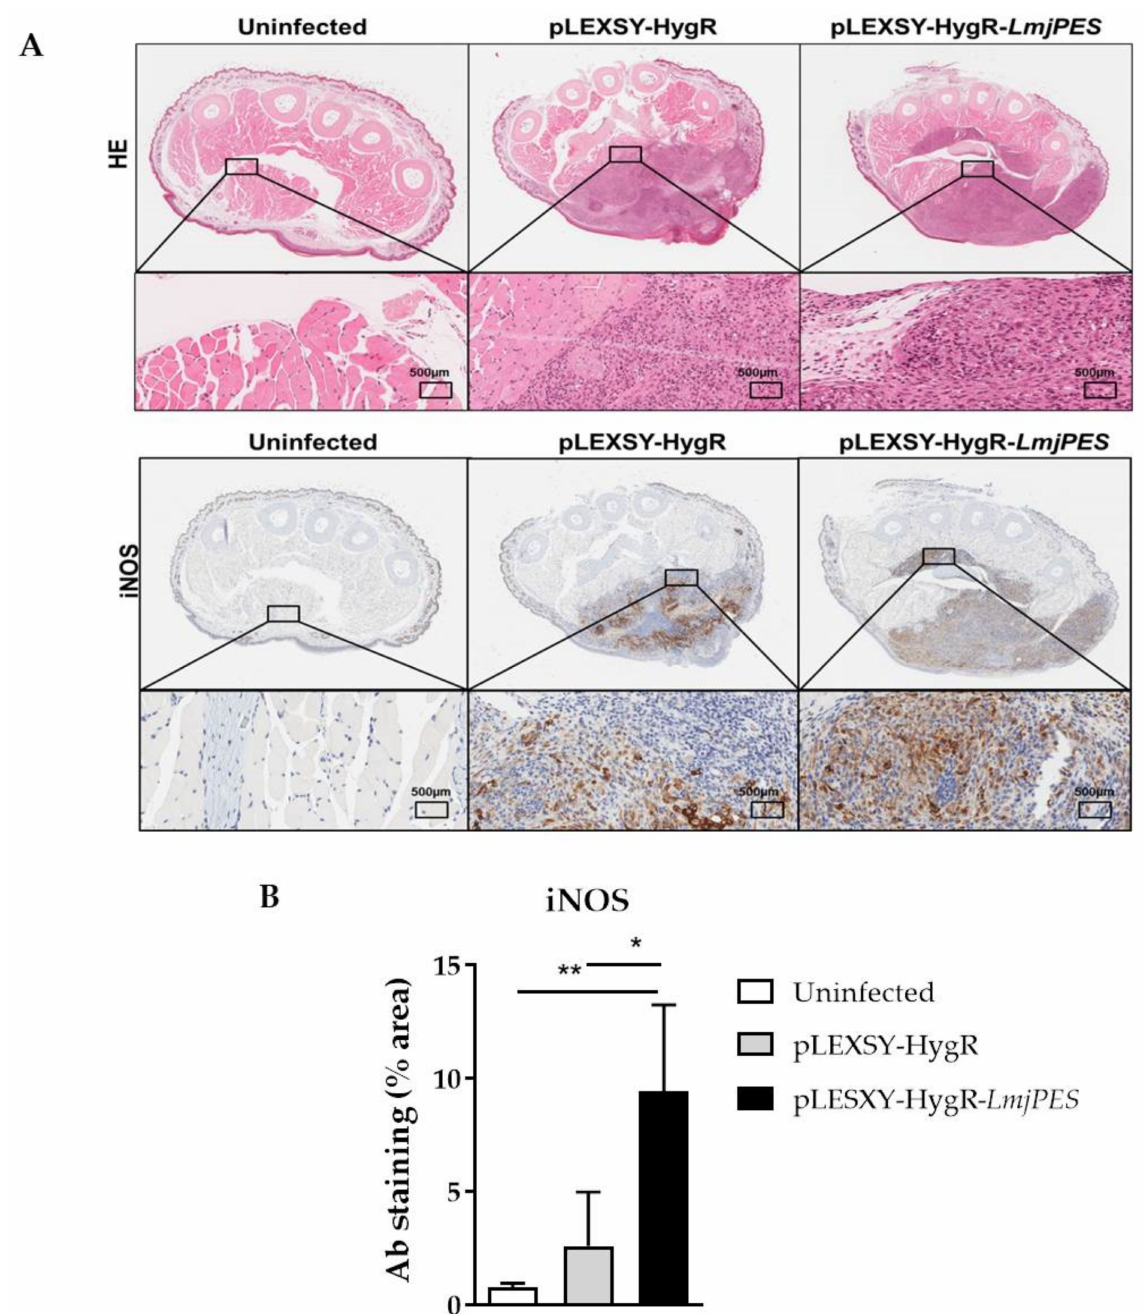
Figure 8. Histopathology and immunohistochemistry results of the footpad sections. Five weeks after last inoculation, animals were sacrificed to determine the footpad inflammation by histology staining methods. ( A ) Hematoxylin-eosin and immunohistochemical staining for iNOS in footpad sections from mice infected with LmjPES -overexpressing and non- overexpressing parasites. ( B ) The differences in the area of footpad sections stained with antibodies of iNOS from animals infected with LmjPES -overexpressing parasites compared to those inoculated with control (cells harboring pLEXSY-HygR plasmid). The bars represented the means ( ± SD) (* p < 0.05, ** p <